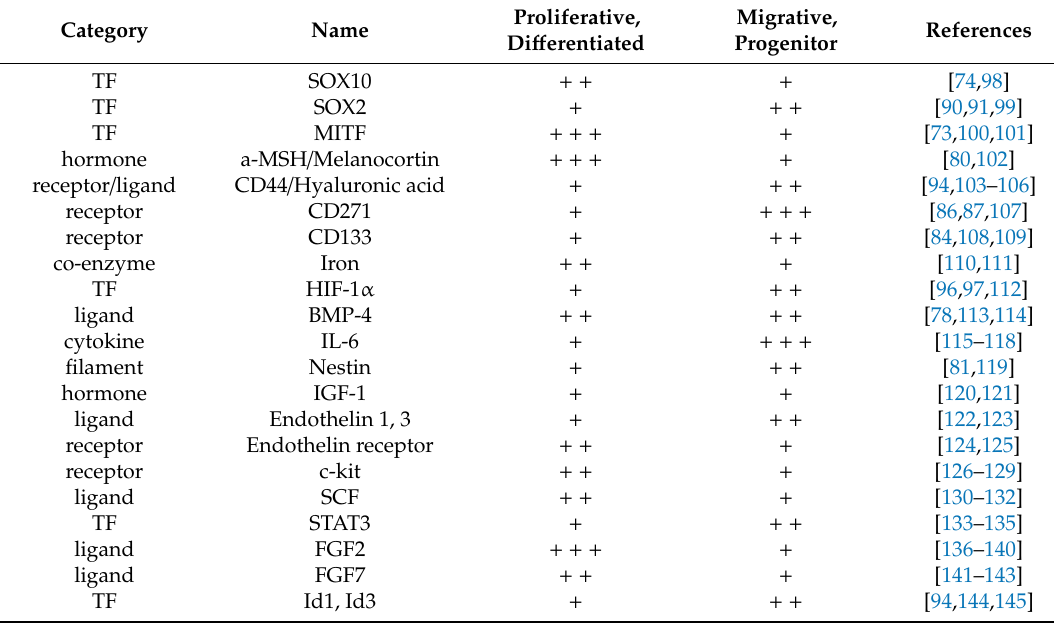
Table 1. List of molecules contributing either to a di ff erentiated, proliferative phenotype or to a migrative, neural crest